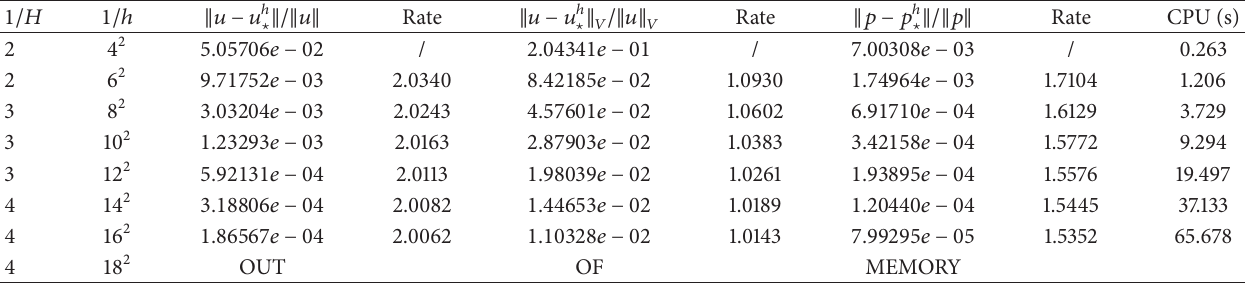
Table 5: Convergence of two-level Newton correction